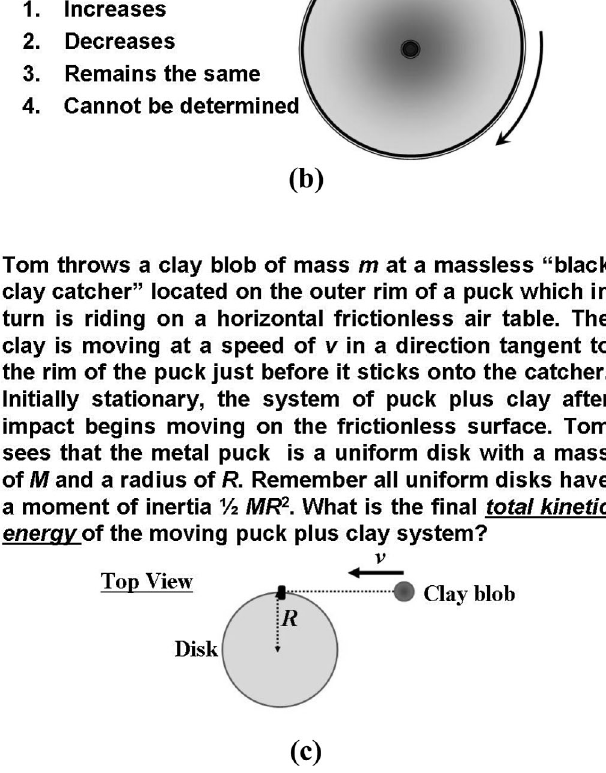
FIG. 2. A sequence used for a large-scalewritten test. (a) and (b) are conceptual questions; (c) is an open-ended synthesis